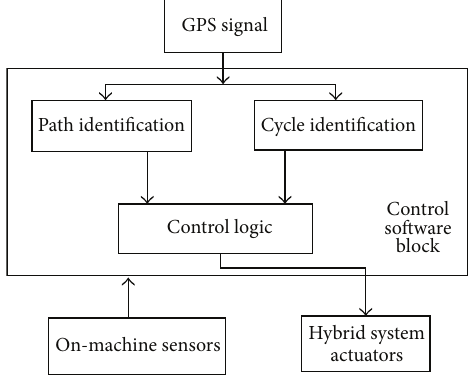
Figure 9: Rule-based control block diagram.